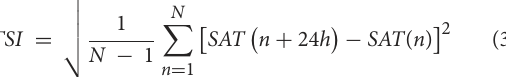
Stykkisholmur/Reykjavik, Iceland (Hurrell and Deser,